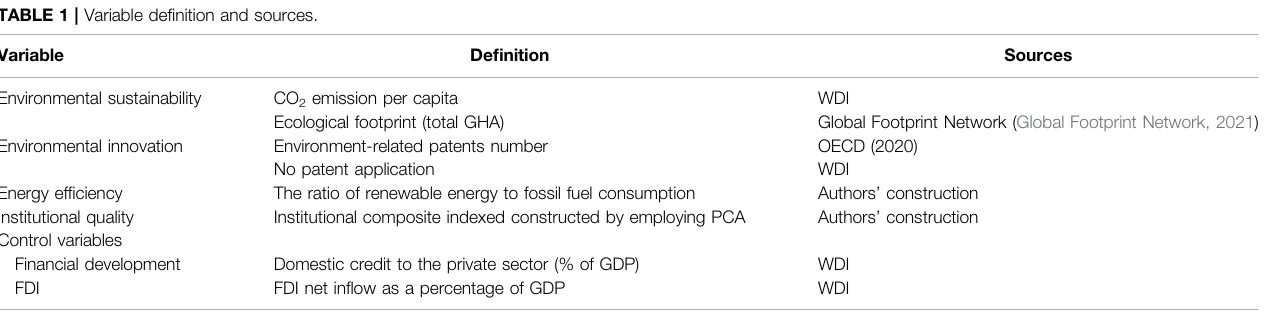
TABLE 1 | Variable de fi nition and sources.